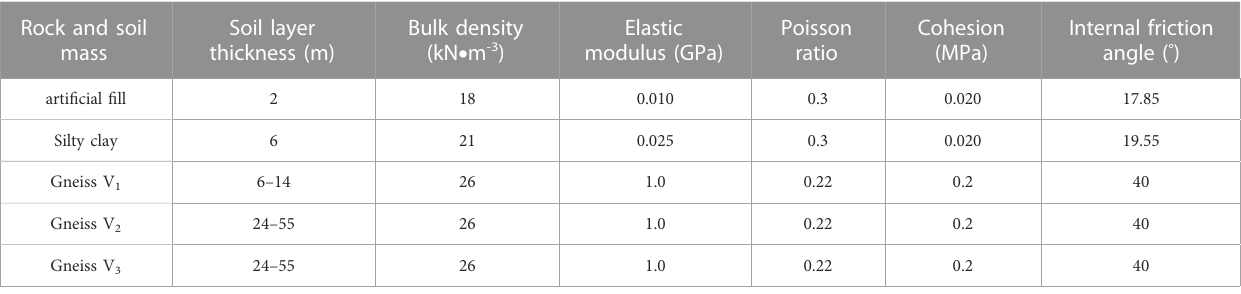
TABLE 2 Slope rock mass